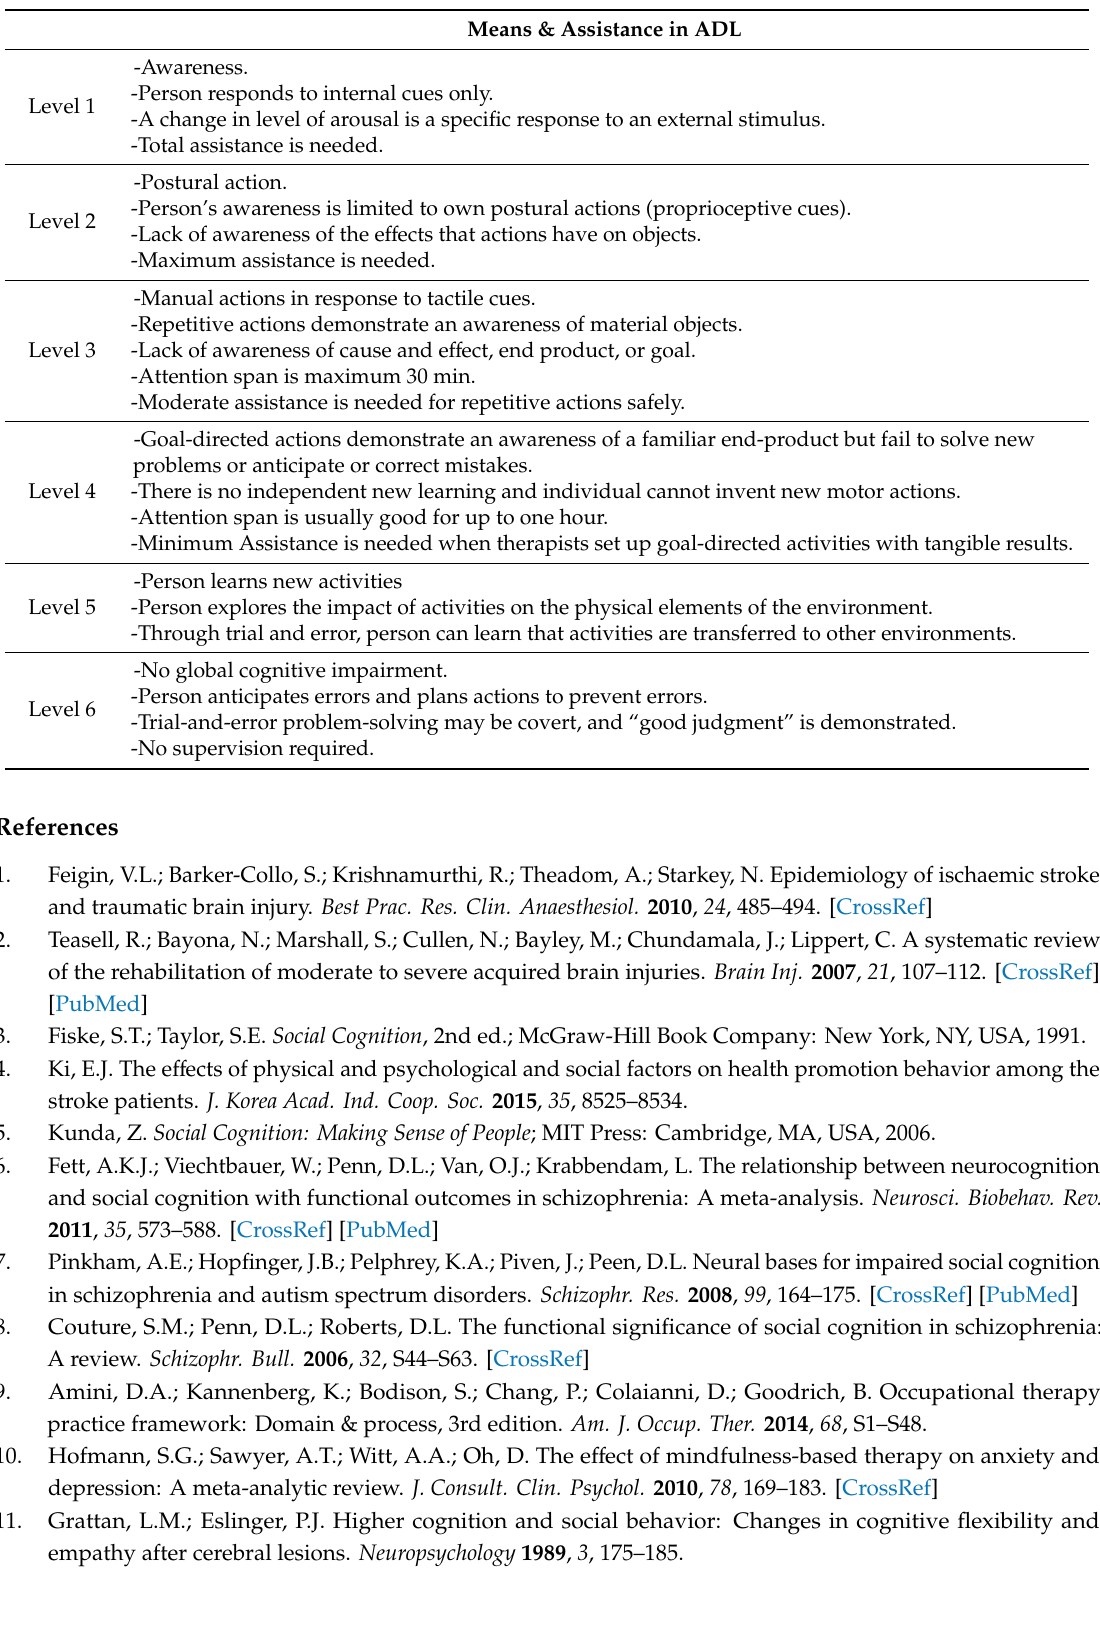
Table A1. References on ACL by Allen cognitive disability